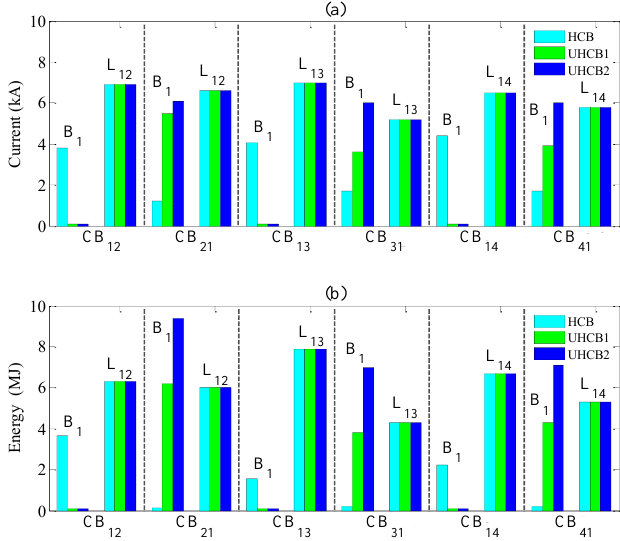
Fig. 13. (a) Maximum interrupted current and (b) absorbed energy in different DC circuit breakers during DC bus and line faults